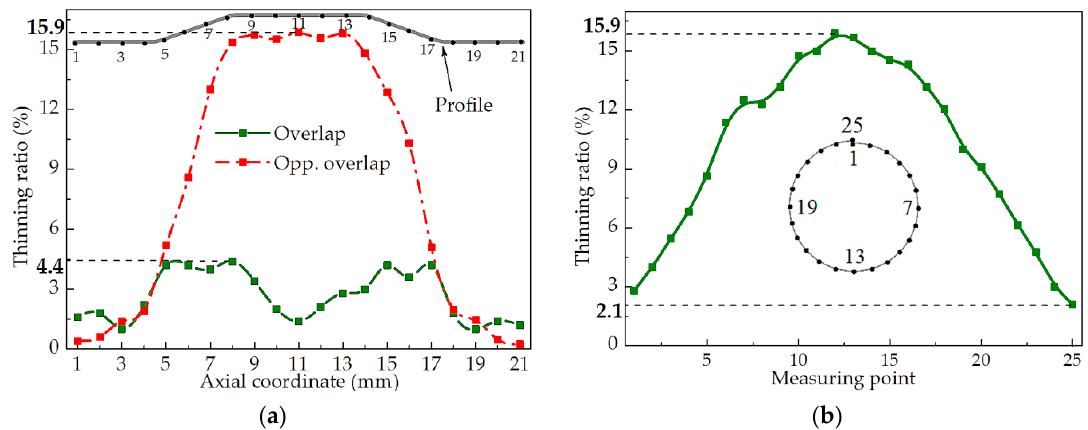
Figure 15 . Thinning ratio distribution ( a ) along axial direction; ( b ) at middle cross-section.